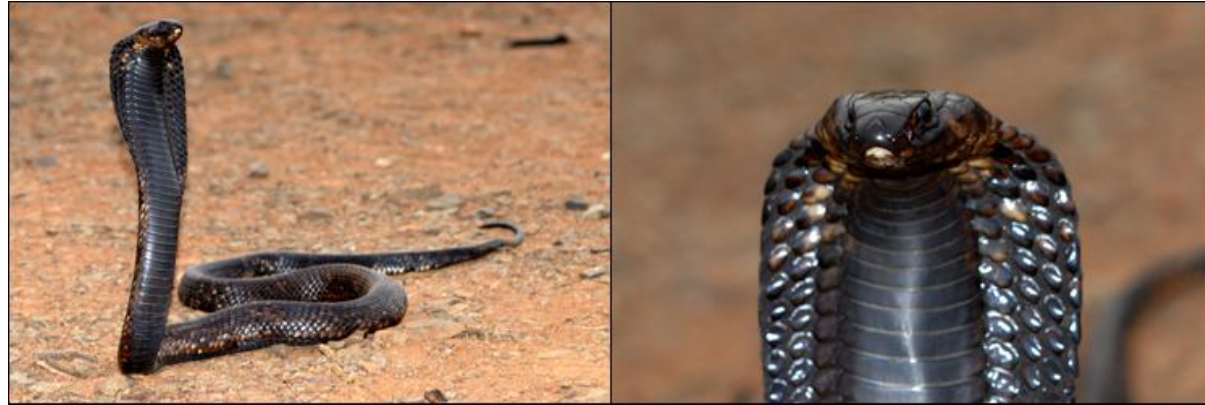
Figure 1. Egyptian cobra ( Naja haje legionis ), environs of Fort Bou-Jérif, west of Guelmim, Morocco (photo by M. Aymerich, 2006).